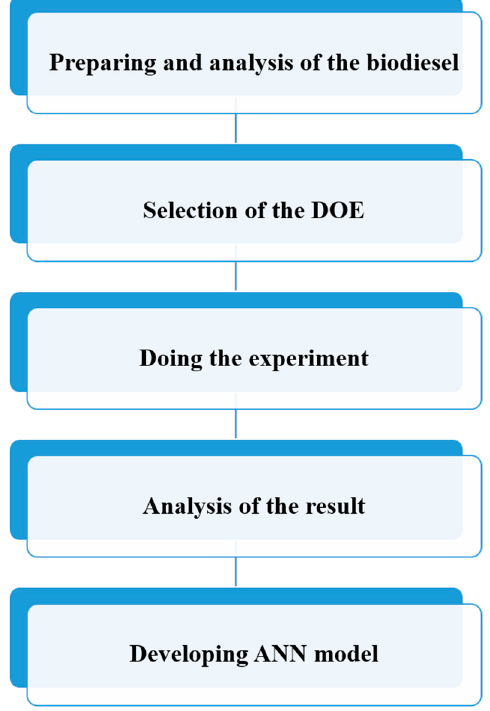
Figure 1. Flow chart of the study steps.